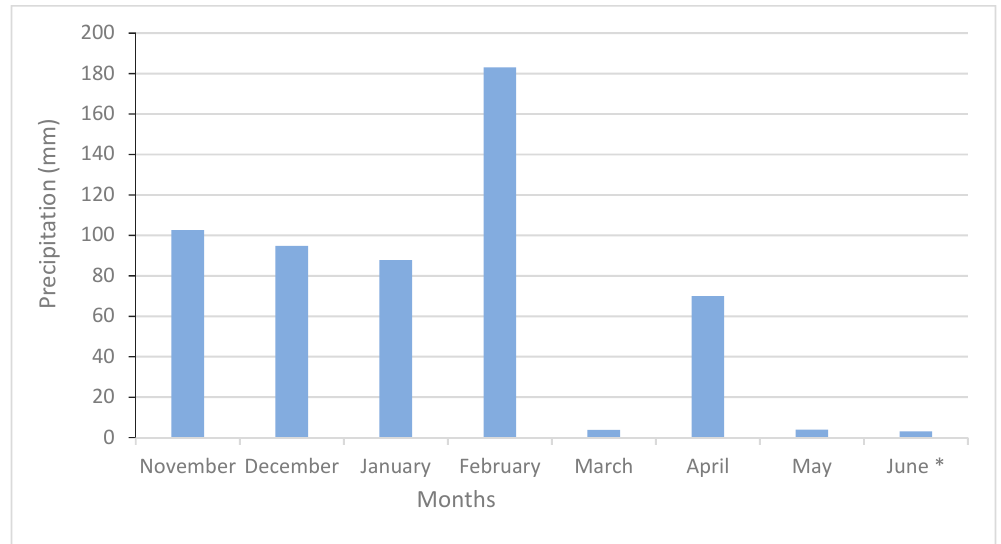
Figure A1. Soil temperature data at the surface (TmnG1) and at 15 cm depth (Tmn15) recorded by the meteorological station of Escola Superior Agrária de Bragança.